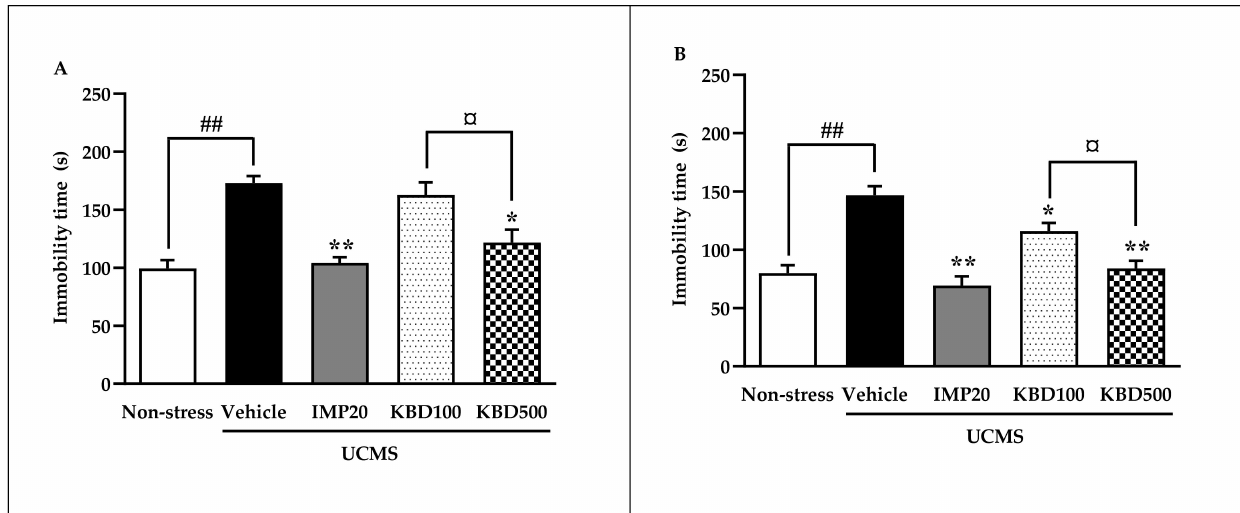
Figure 2. Effect of daily imipramine and KBD formula treatments on UCMS-induced hopeless behavior in the forced swimming test ( A ) and tail suspension test ( B ). Increased immobility times indicate hopeless behavior. Each data column represents the mean ± S.E.M. ( n = 10–12 in each group). ## p < 0.001 vs. vehicle-treated non-stress group. * p < 0.05 and ** p < 0.001 vs. vehicle-treated UCMS group. ¤ p < 0.05 compared between doses of the KBD